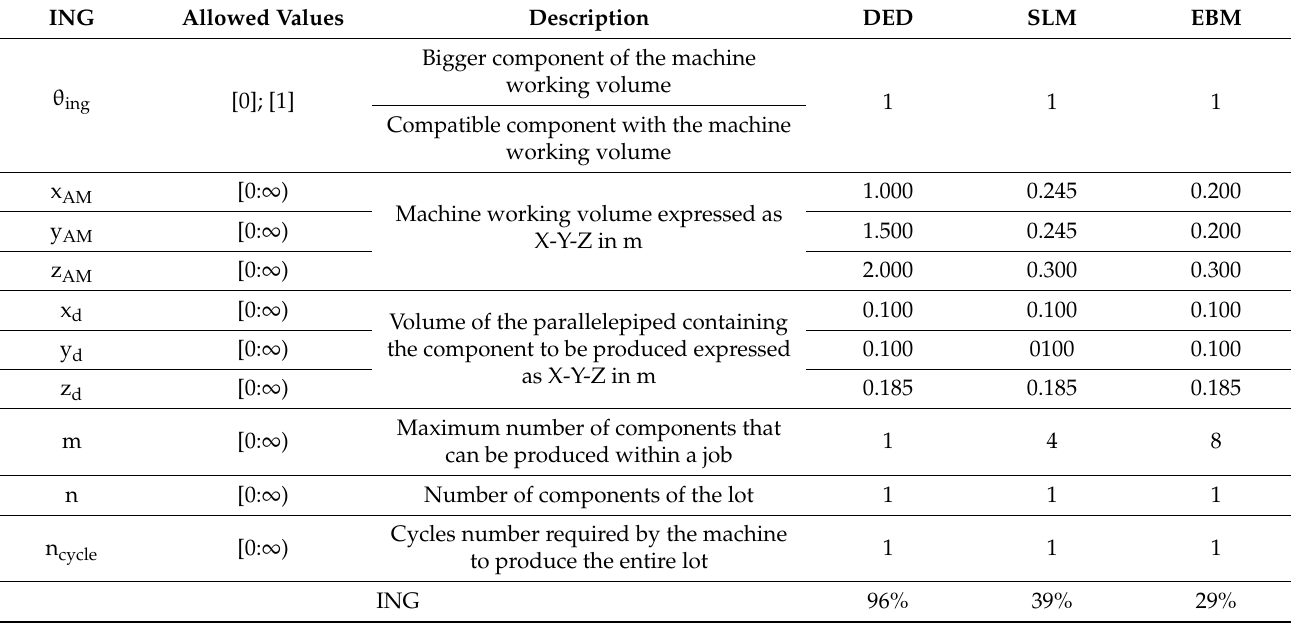
Table 3. Overall dimensions study (ING) calculation for the FDM head for traditional plastics. ING